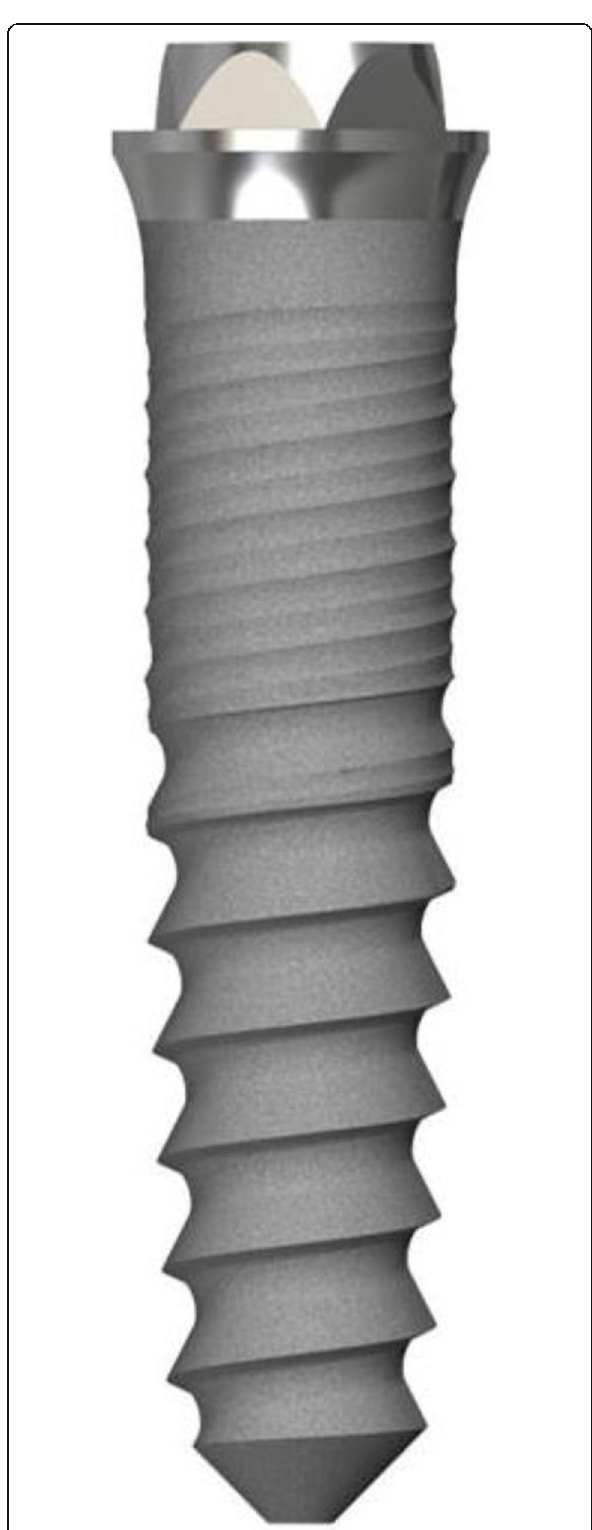
Fig. 2 Design of the utilized implant